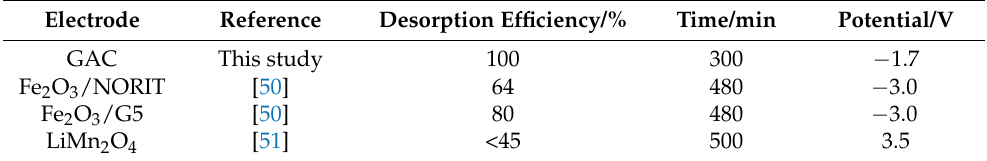
Table 2. The comparison of desorption